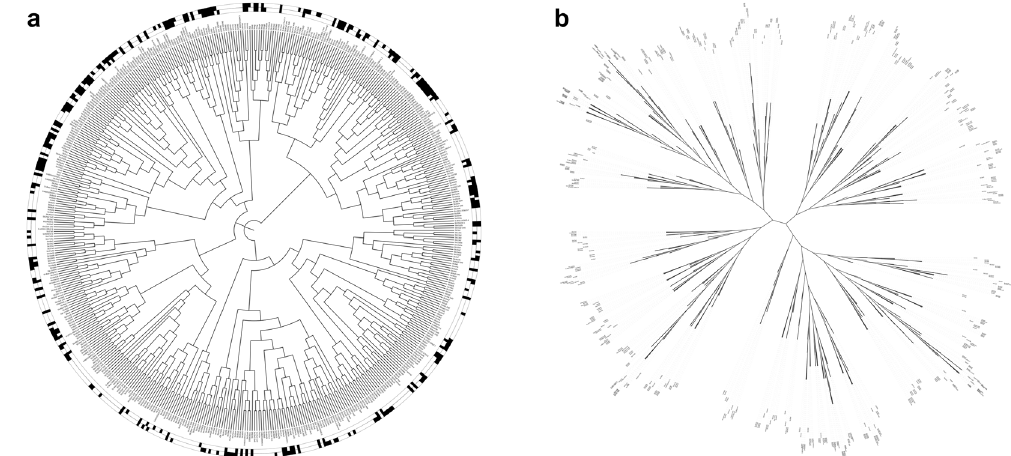
Figure 5. Zebrafish neutrophils and non-neutrophil cells express distinct subsets of SLC transporter proteins. Scalable phylogenetic trees in both ( a ) circular and ( b ) unrooted display modes indicate evolutionary relationships between SLC transporter proteins in zebrafish (branch lengths are not proportional to genetic distance; see Supplementary Fig. S5 for trees with proportional branch lengths). In ( a ), for both neutrophil (inner circle) and background cell (outer circle) expression data, expressed proteins are marked with a black box, whereas proteins not expressed are unmarked.